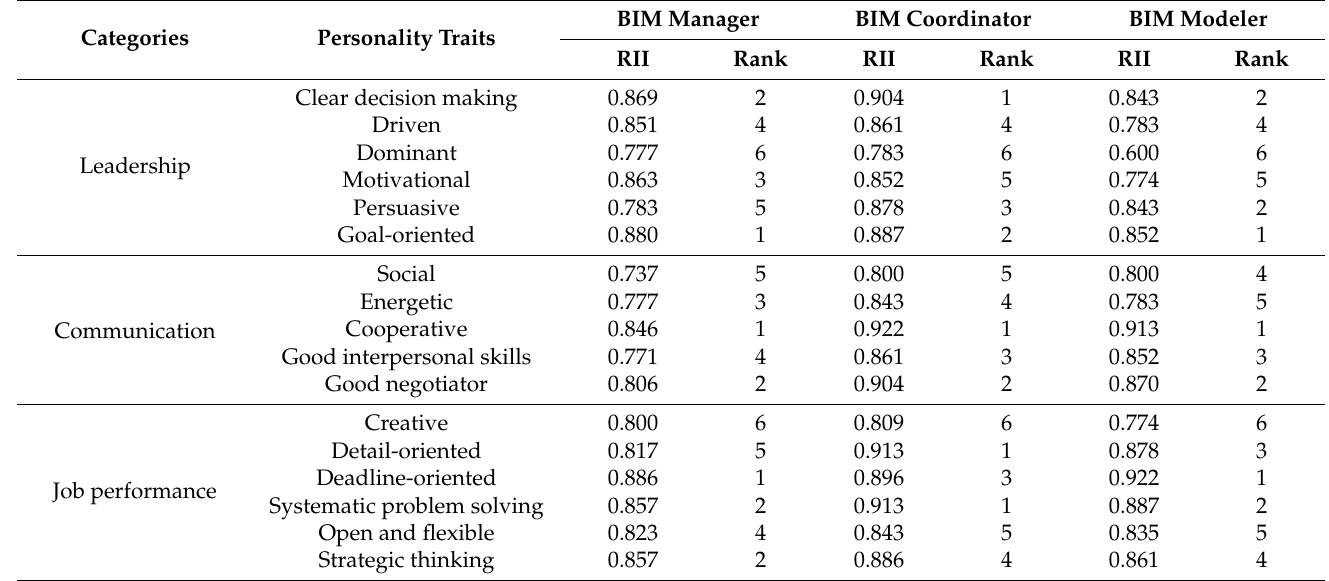
Table 6. The required level of personality traits, in relation with role and responsibilities, ranked by BIM staff.